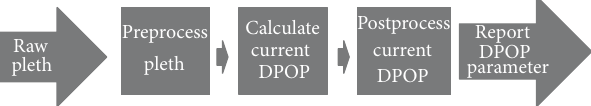
Figure 1: High-level schematic overview of the DPOP